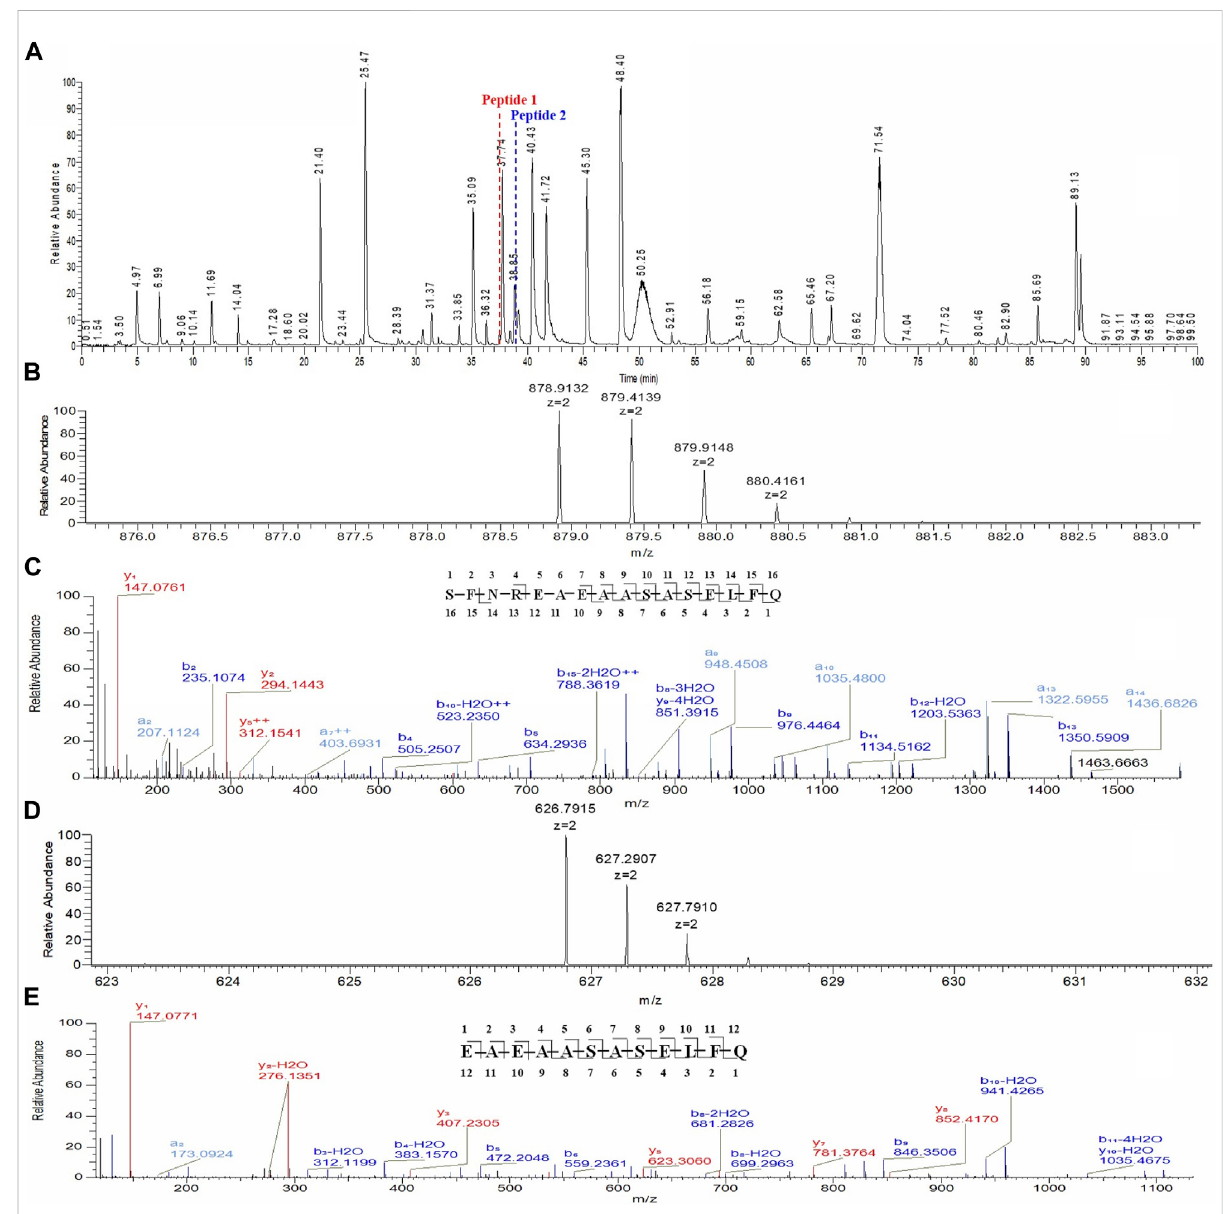
FIGURE 4 Lys-C/Trypsin peptide mapping and tandem mass analysis of Fraction-2. (A) : reduced Lys-C/Trypsin peptide mapping TIC of Fraction-2, most of the peptides were identi fi ed except Peptide 1 and Peptide 2; (B) : MS pro fi le of Peptide 1; (C) : MS/MS pro fi le of Peptide 1, de novo sequencing yielded the peptide sequence of “ SFNREAEAASASELFQ, ” with the observed fragment ions labeled; (D) : MS pro fi le of Peptide 2; (E) : MS/MS pro fi le of Peptide 2, de novo sequencing yielded the peptide sequence of “ EAEAASASELFQ, ” with the observed fragment ions